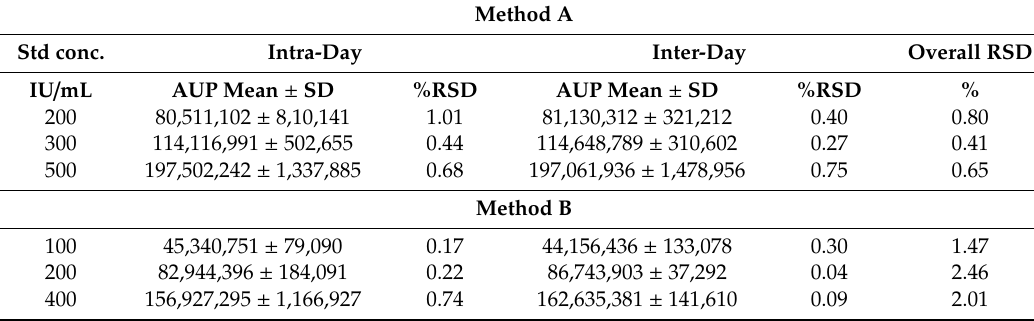
Table 2. Precision for determination of insulin in Hum R for methods A and